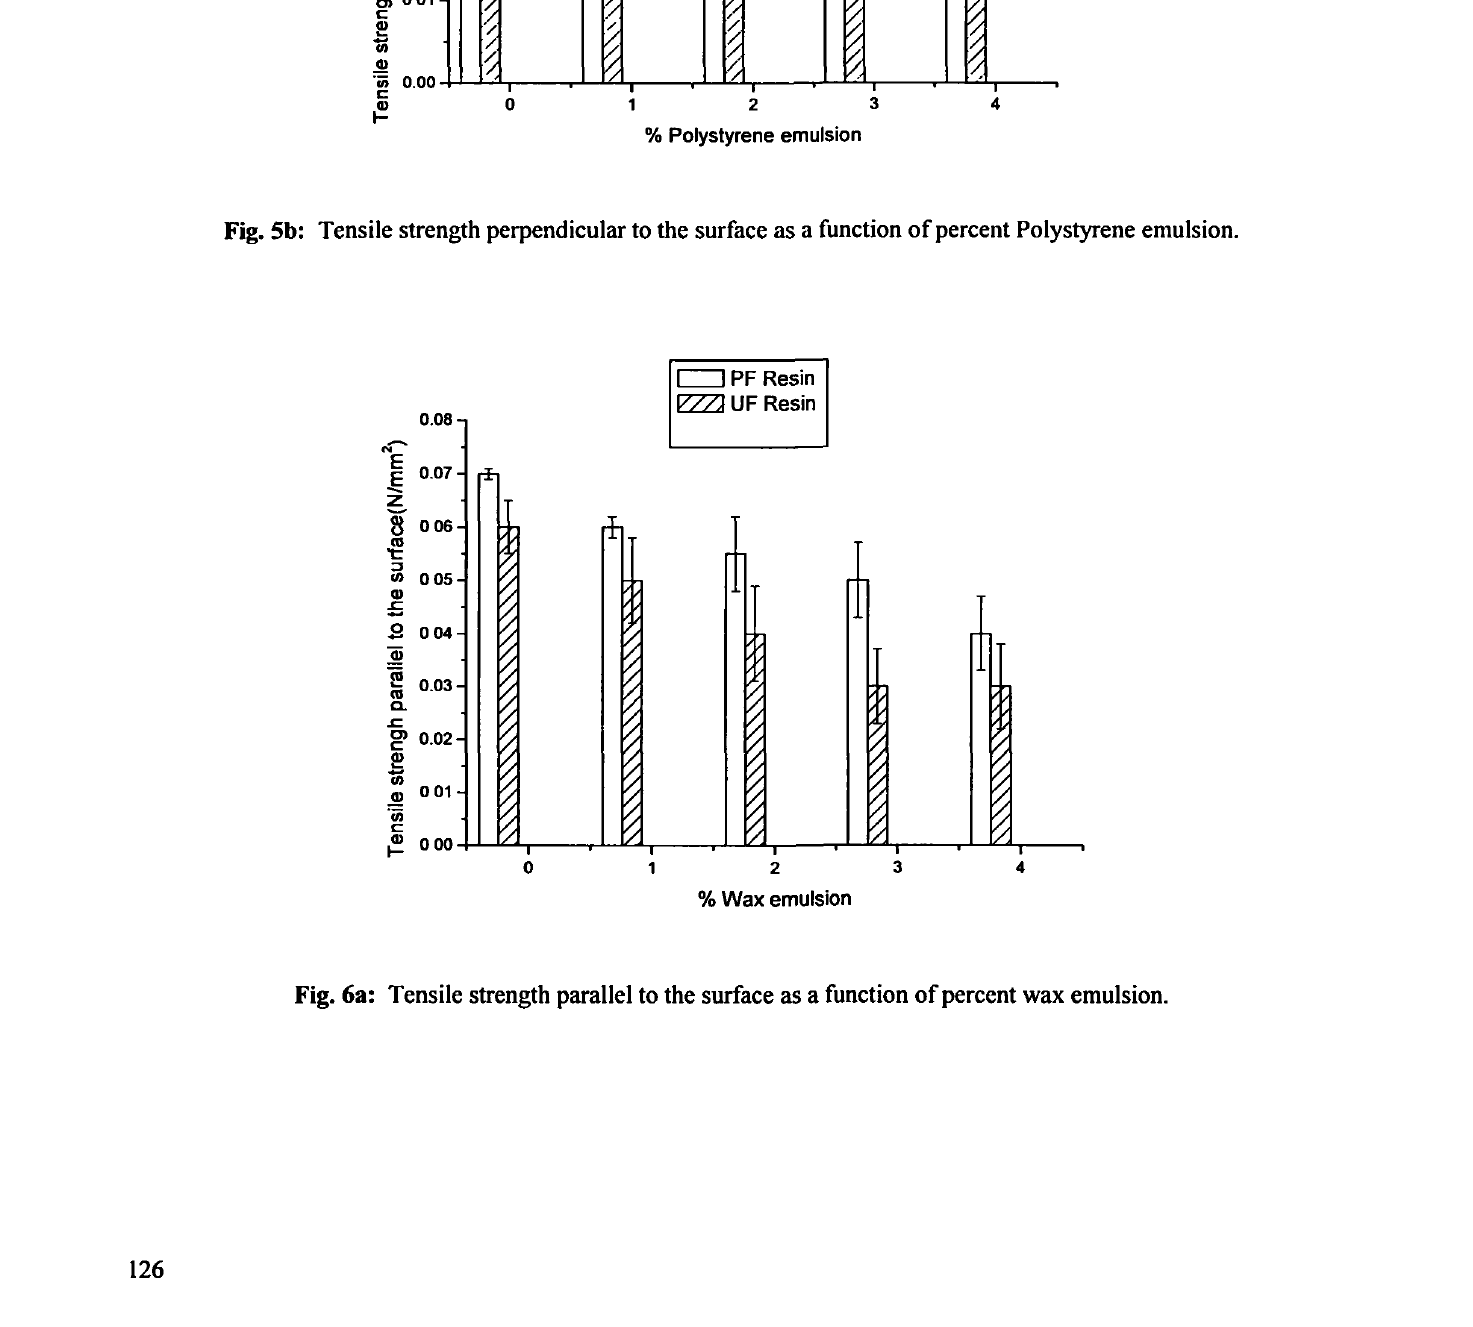
Fig. 6a: Tensile strength parallel to the surface as a function of percent wax emulsion.